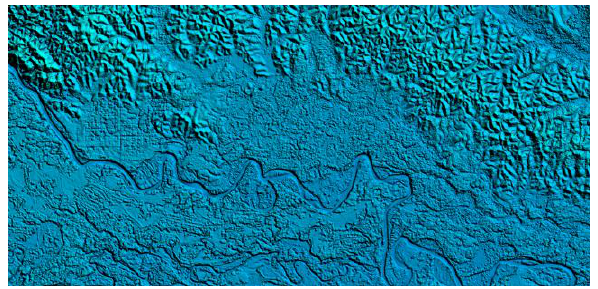
Figure 11. DTM from this research (National DEM)